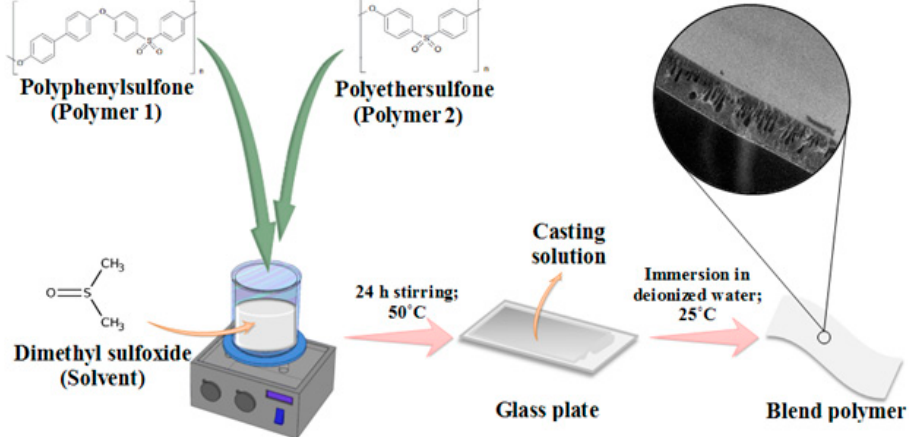
Figure 2. Schematic diagram for membranes preparation. Table 1. Compositions of PPSU/PSU blend solutions and PWP of the membranes.